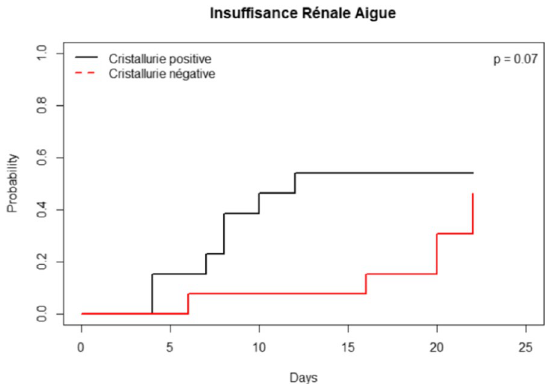
Fig. 1 Probability of acute kidney injury in patients with (black line) and without crystalluria (red line) F‑030 Cytogenetic Abnormalities and Risk for Acute Kidney Injury in Critically Ill Patients with Acute Myeloid Leukemia (AML)